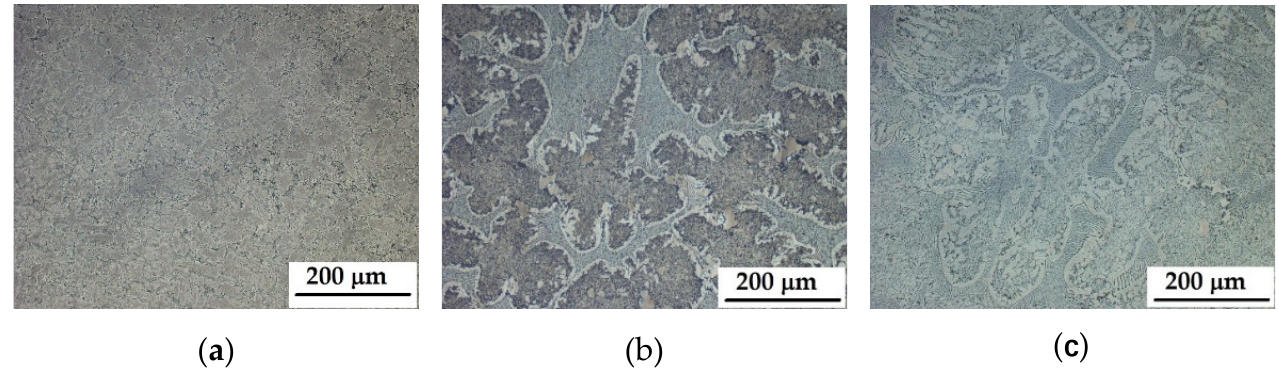
Figure 5. Structure of sample B: ( a ) Sample B—as-cast state; ( b ) Sample B50 after DS at rate 50 mm/h; ( c ) Sample B20 after DS at rate 20 mm/h.